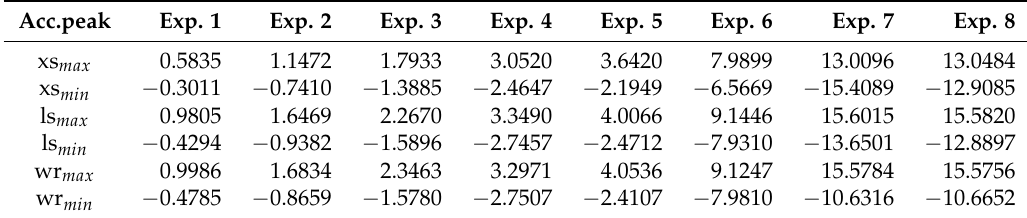
Table 5. Acceleration and deceleration average peaks (m/s 2 ) for every experiment and accelerometer.